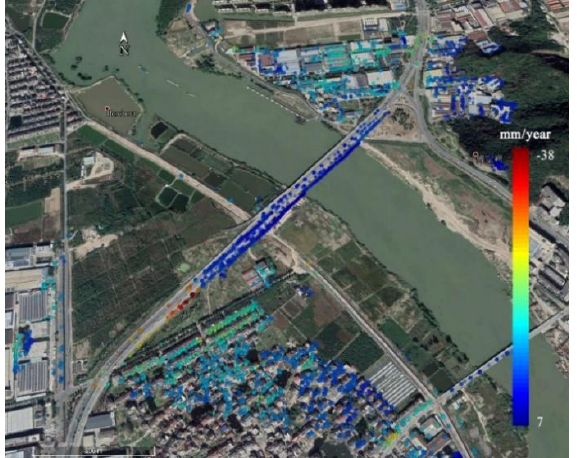
Figure 3. The deformation velocity is obtained by selecting points based on amplitude information.